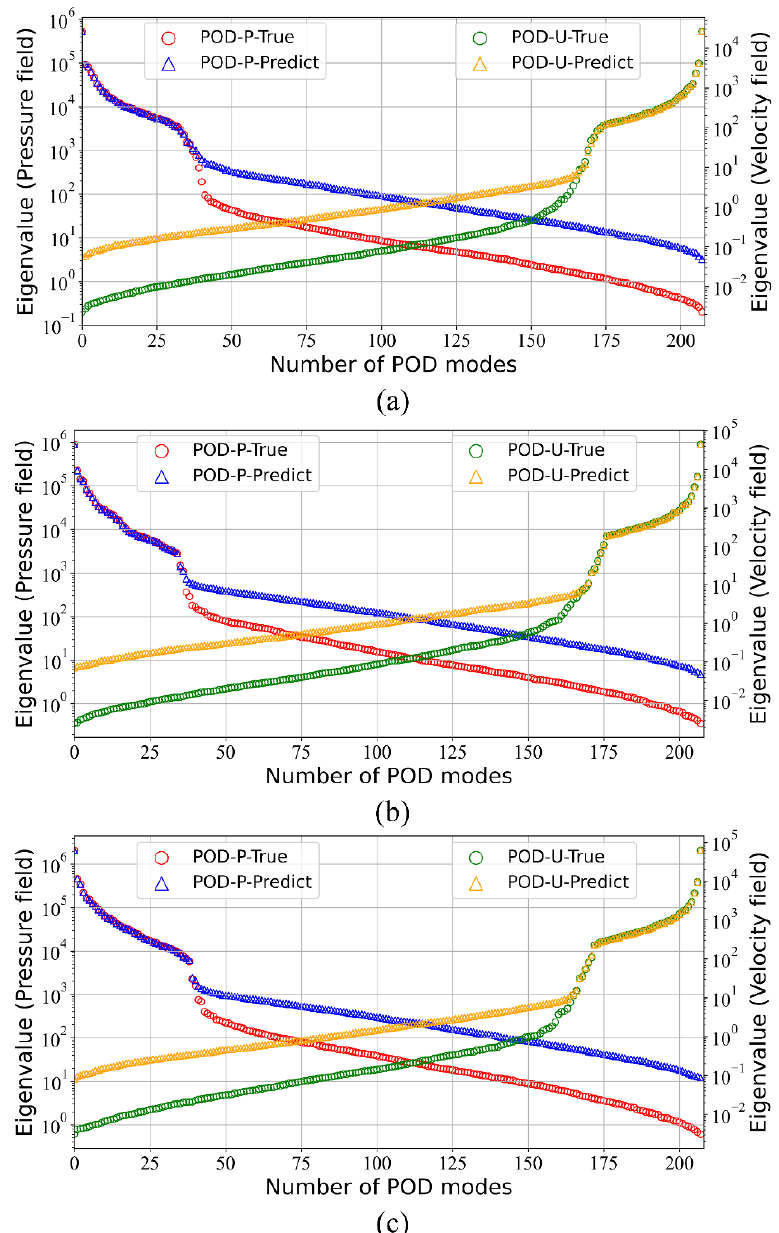
Figure 14. POD eigenvalues calculated from the true and predicted flow fields CFD and CNN- DCNN model prediction: ( a ) case 1: NACA9712, AOA = 0°, Re = 3 × 10 6 ; ( b ) case 2: NACA2412, AOA model prediction: ( a ) case 1: NACA9712, AOA = 0 ◦ , Re = 3 × 10 6 ; ( b ) case 2: NACA2412, AOA = 5 ◦ , = 5°, Re = 5 × 10 6 ; ( c ) case 3: NACA6212, AOA = 3°, Re = 7 × 10 6 . Re = 5 × 10 6 ; ( c ) case 3: NACA6212, AOA = 3 ◦ , Re = 7 × 10 6